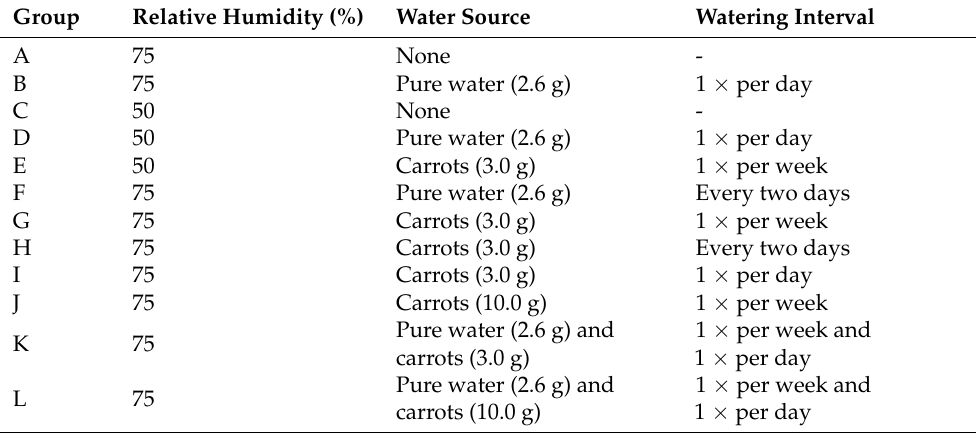
Table 1. Feeding groups of T. molitor